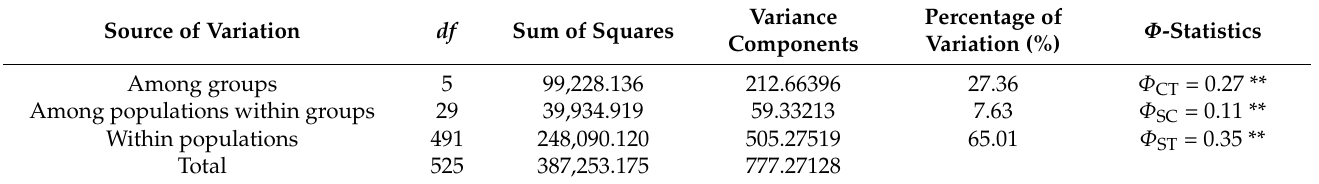
Table 2. AMOVA among different geographic groups, inter- and intra-populations of C. spinosa